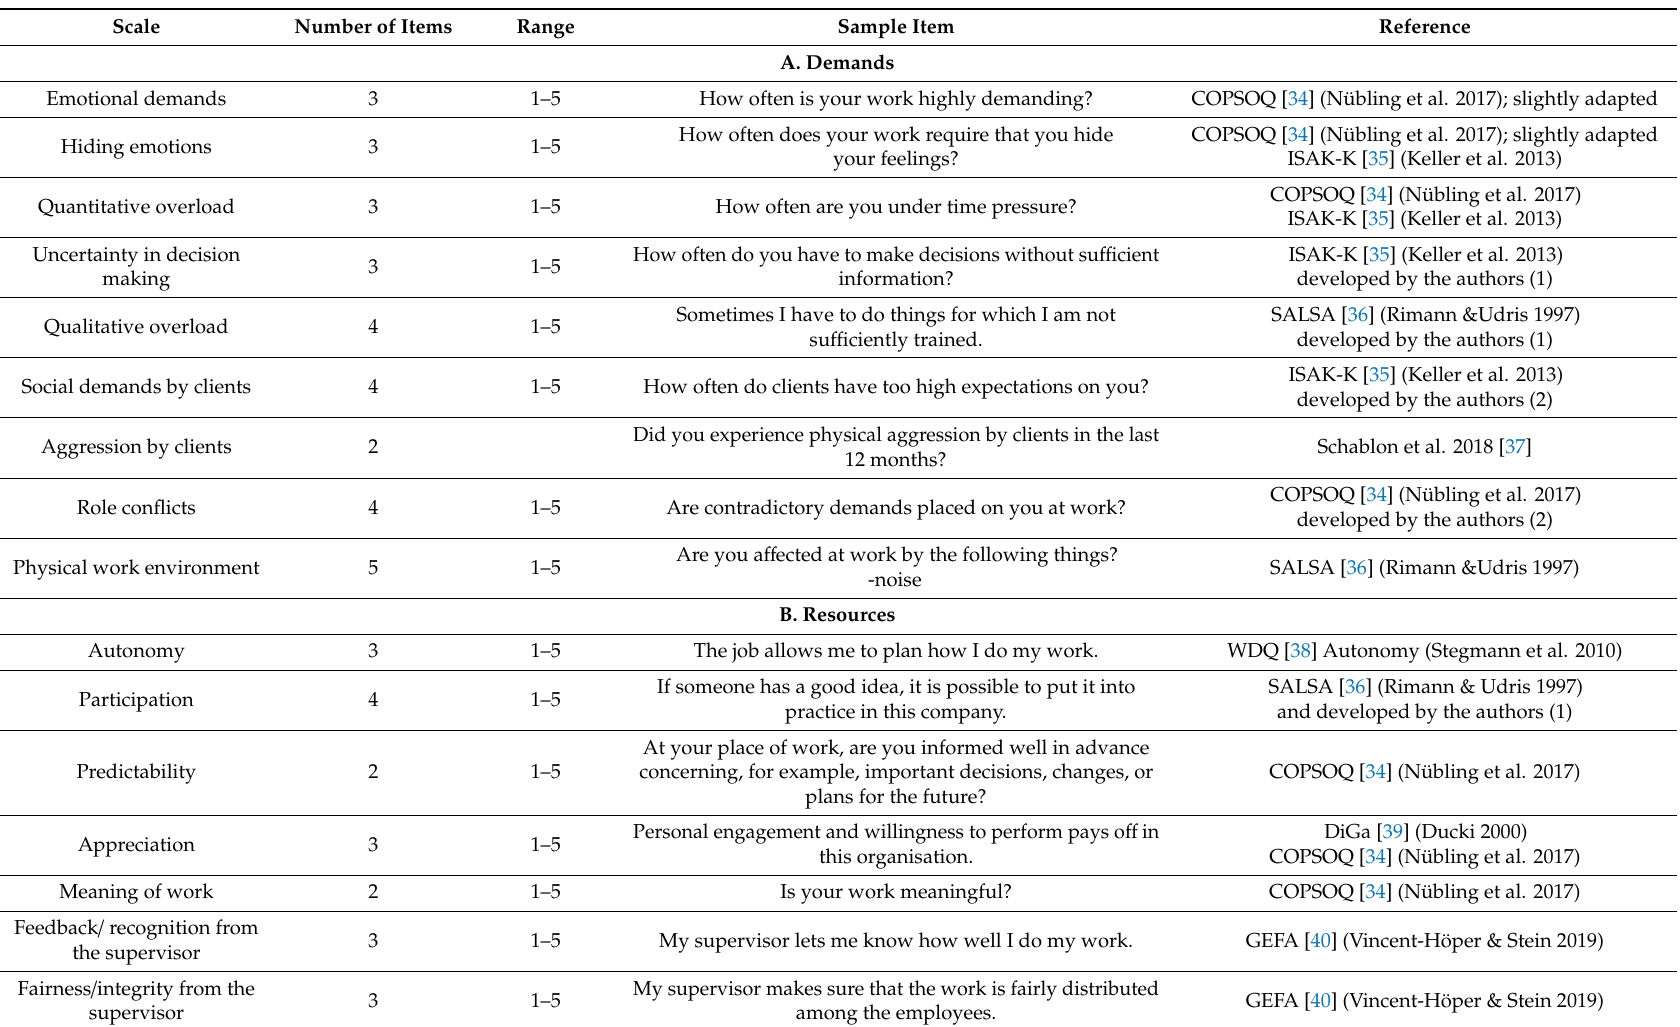
Table 1. Scales of the